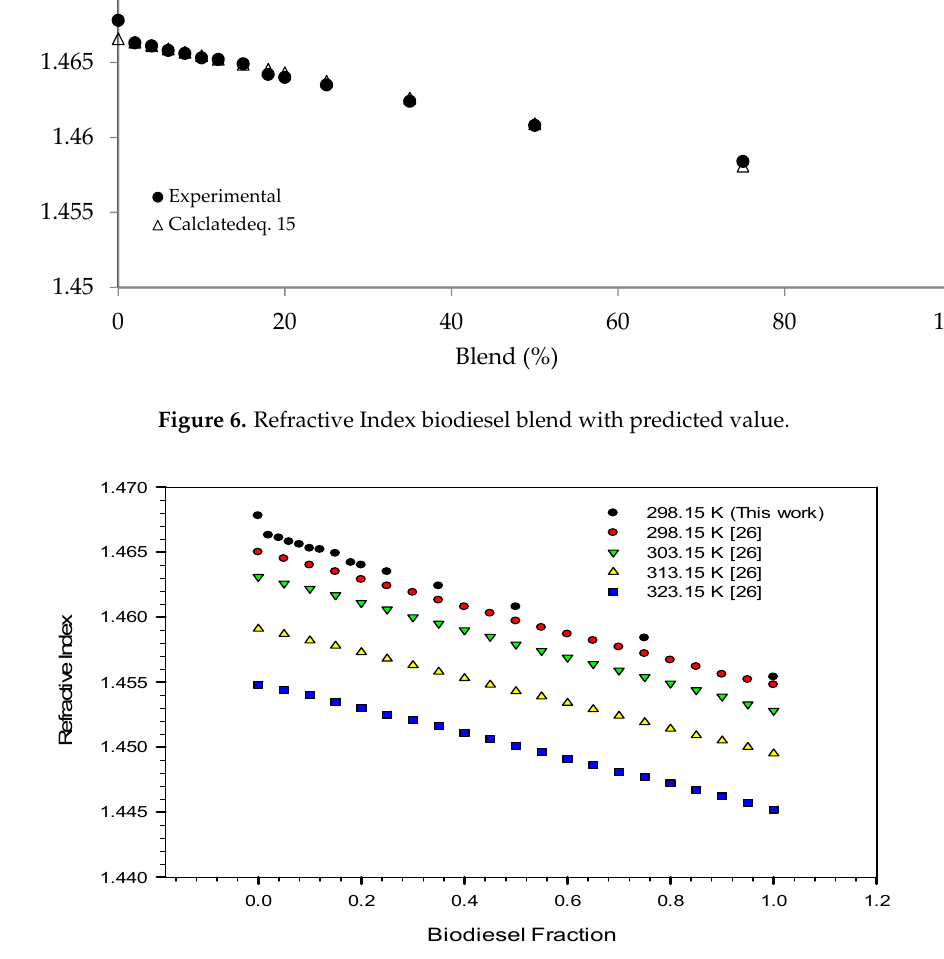
Figure 7. Refractive Index variation of different blend at different temperatures.